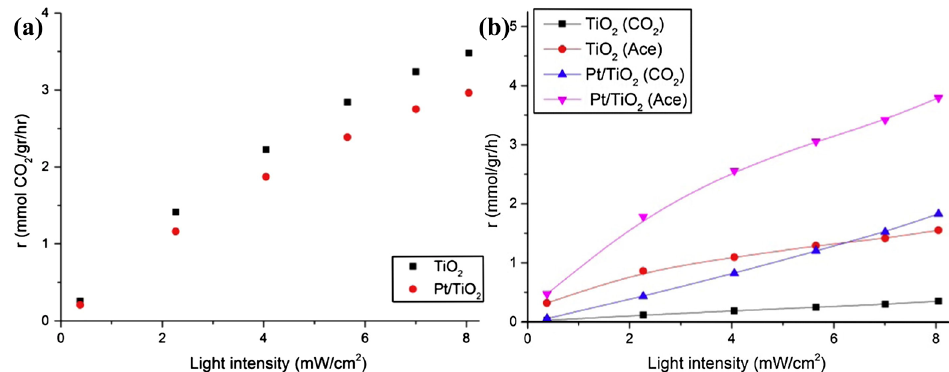
Figure 64. ( a ) CO 2 production rate (r) versus light intensity for oxidation of propane and ( b ) CO 2 and acetaldehyde production rate (r) versus light intensities for the photocatalytic oxidation of ethanol on TiO 2 and Pt-TiO 2 . Reproduced with permission from [89].